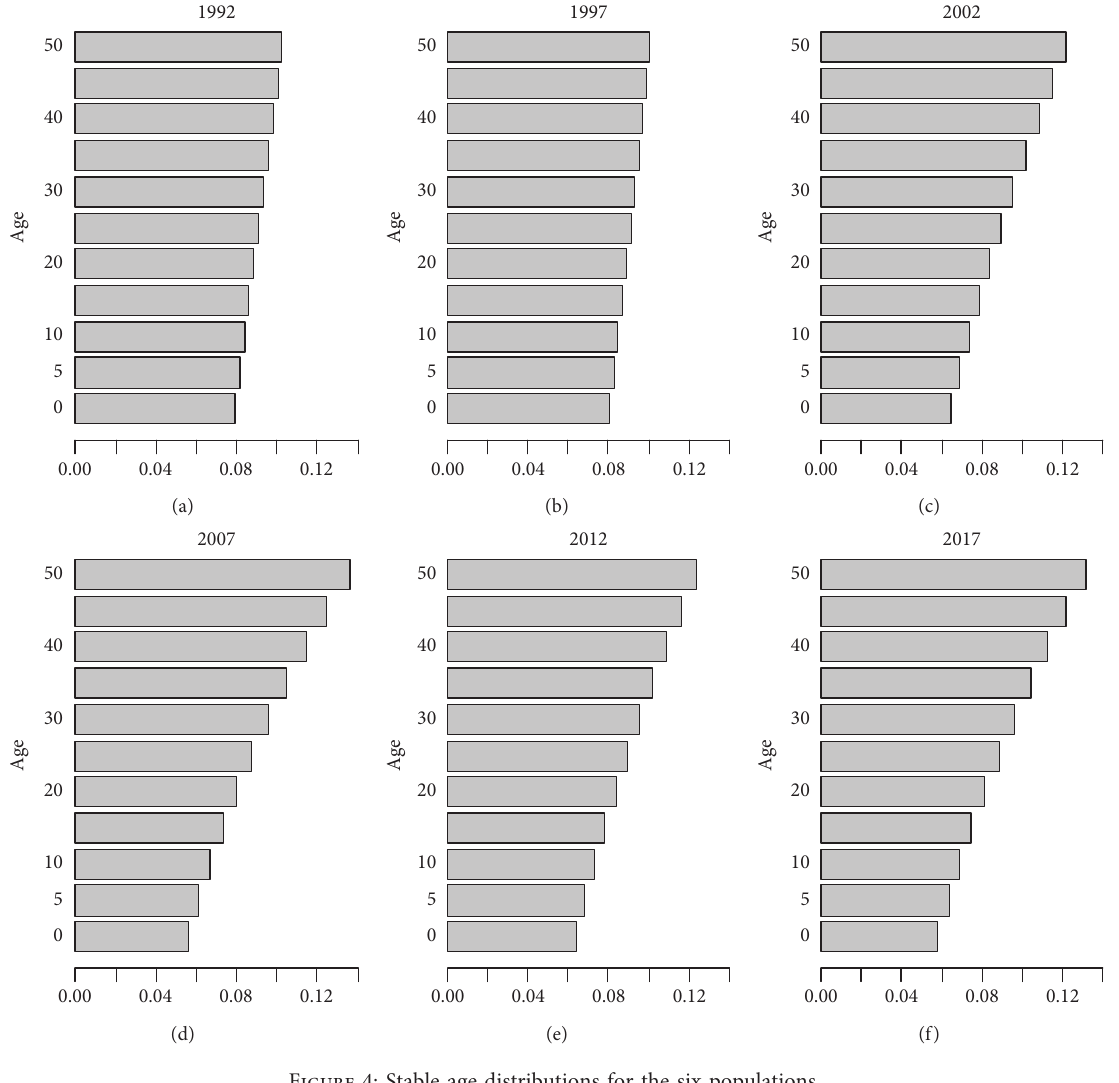
Figure 4: Stable age distributions for the six populations.